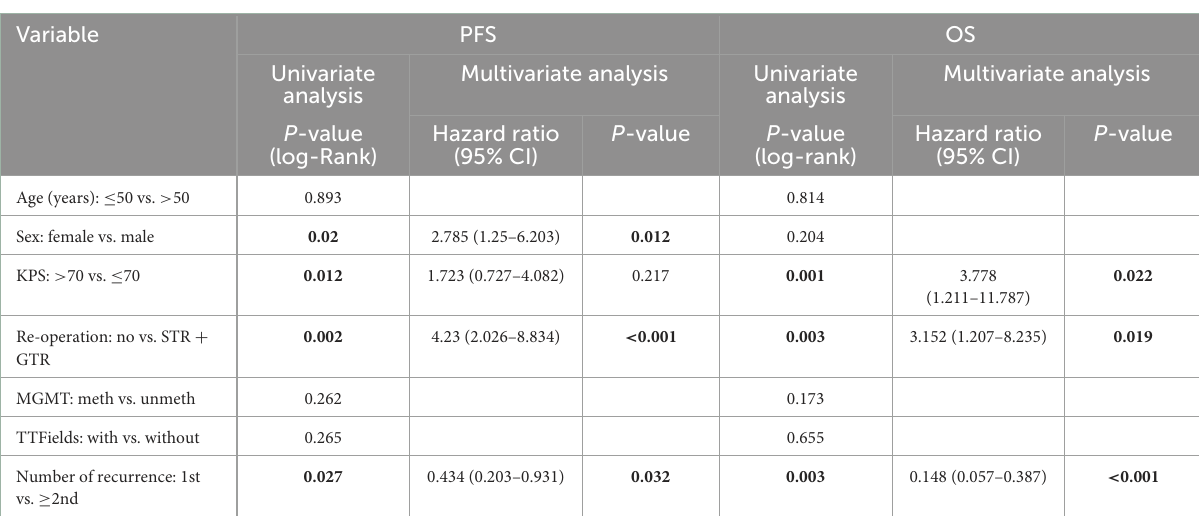
TABLE 3 Univariate and multivariate analysis for PFS and OS of rGBM.